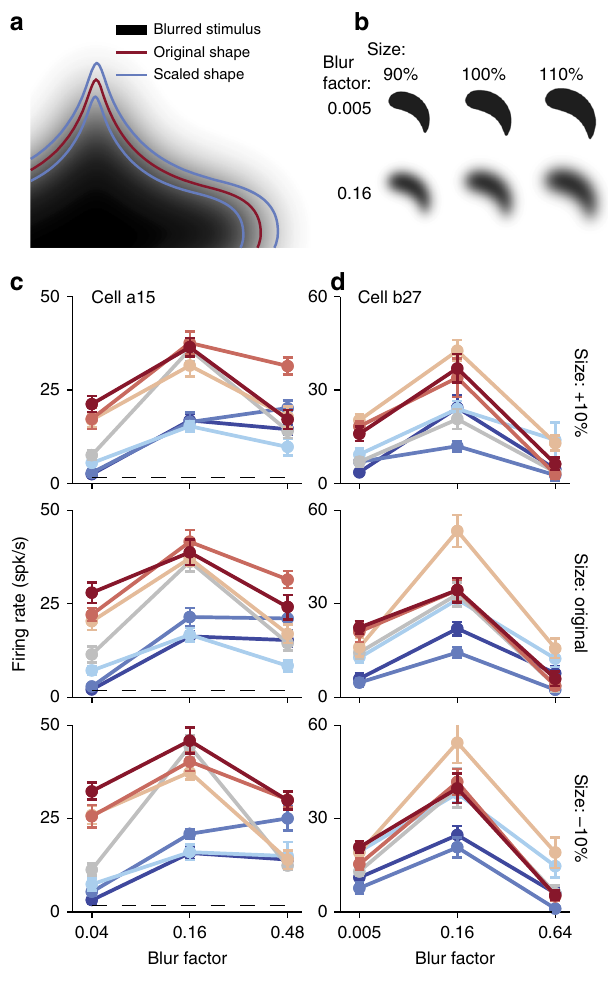
Fig. 4 Stimulus size does not explain blur selectivity. a A blurred stimulus ( β = 0.16) has an increased foreground area, de fi ned as the number of pixels distinct from the background, compared to its original boundary prior to blurring (red). Stimuli scaled by ± 10% are shown for comparison (blue), and correspond to luminance thresholds approximately 1/3 and 2/3 of maximum, respectively. b Example scaled and blurred stimuli used to assess a potential size confound. c , d Results of the size control experiment for cells a15 and b27 demonstrate increased responses for intermediate blur irrespective of stimulus size. Line color represents stimulus identity per Fig. 2d, f. For both neurons, responses were not signi fi cantly in fl uenced by size ( p = 0.45 and p = 0.18, respectively) but signi fi cant variance was found with respect to blur ( p < 0.0001). Error bars indicate